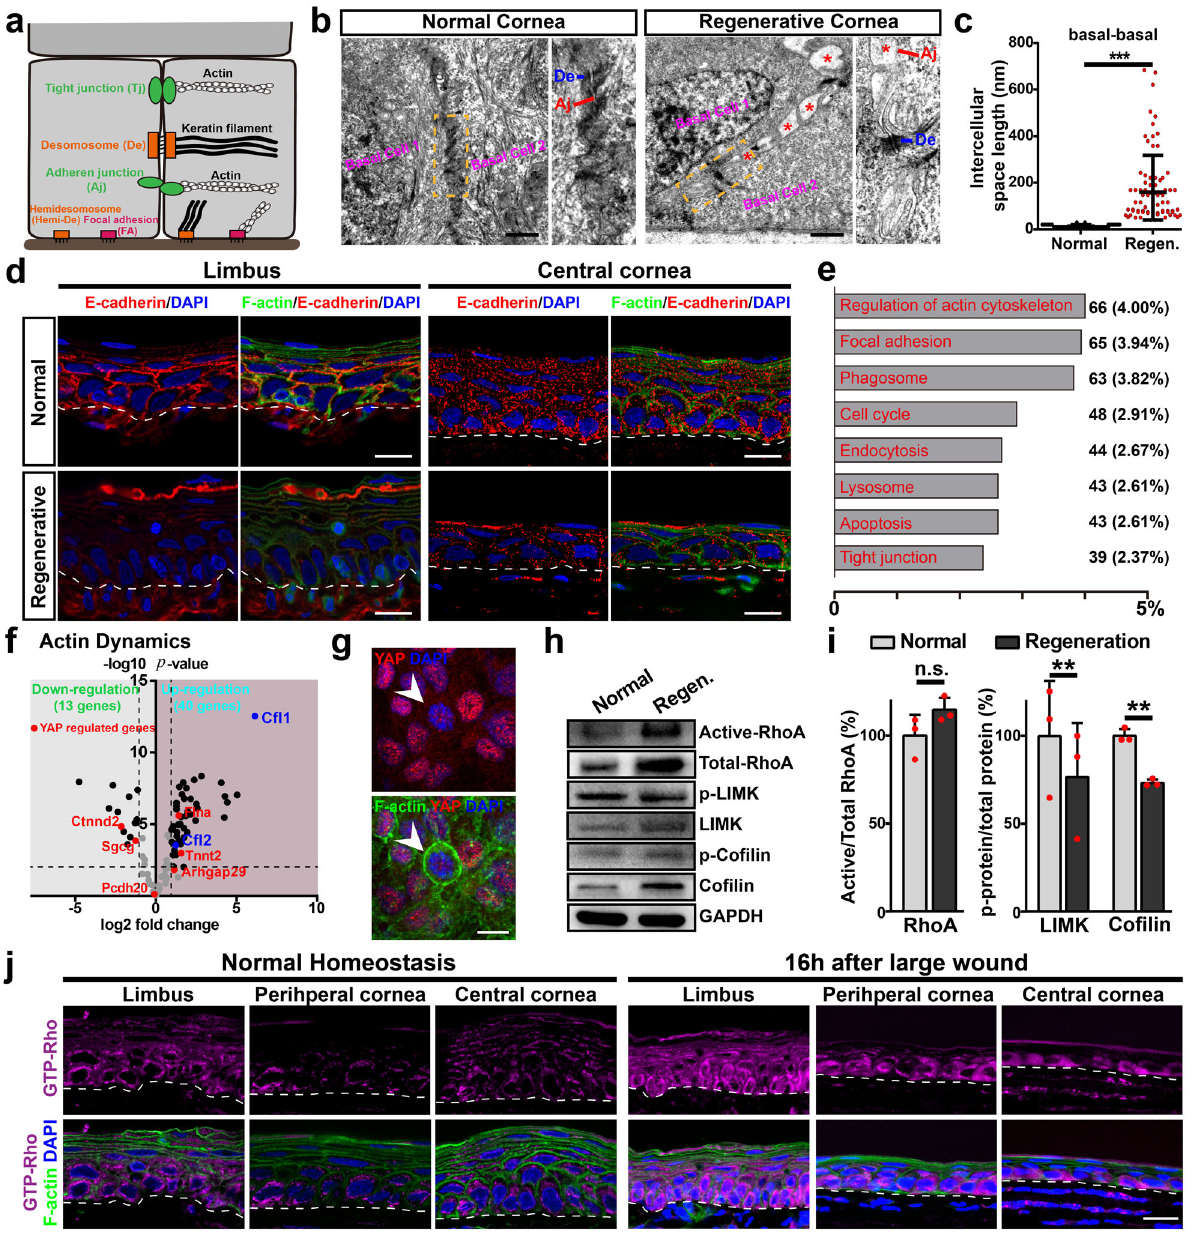
Fig. 4 Loosening of adhesions and disrupted cortical F-actin cytoskeleton during regeneration and repair. a Schematic representation shows three classes of cell – cell adhesions and two classes of cell-ECM adhesions in the corneal epithelium. b TEM images of neighboring epithelial basal cells during normal homeostasis and regeneration at 16 h after large wound. Clear intercellular loosening of Aj at 16 h pw is indicated with asterisks. c Quanti fi cations of intercellular space lengths between neighboring epithelial basal cells during normal homeostasis and regeneration (regen.) at 16 h after large wound. d E-cadherin and fl uorescein-phalloidin stainings of limbal and corneal epithelial cells during normal homeostasis and at 16 h after large wound (regenerative). e Enrichment of differential expressed transcripts in KEGG pathways during corneal wound regeneration. The transcript number and percentage are shown. f Differentially expressed genes that involving actin dynamics during corneal wound regeneration from published genome-wide cDNA microarray data. YAP target genes (red dots and texts) and C fl 1/2, key proteins that regulate actin dynamics, are shown. g YAP and fl uorescein-phalloidin stainings of cultured hCECs. Arrows indicate hCECs exhibit low protein level of YAP with the assembly of cortical F-actin cytoskeleton. h , i Western analysis and quanti fi cation of active RhoA/Total RhoA, p-LIMK/LIMK, and p-Co fi lin/Co fi lin in normal corneal epithelium and regenerative epithelial cells at 16 h after large wound. j Active GTP-bound Rho staining and cortical F-actin cytoskeleton staining during normal homeostasis and regeneration at 16 h after large wound. Scale bars, 1 μ m ( b ) or 20 μ m ( d , g , j ). Data are the mean ± SD, n = 3 experiments ( i ); n.s. not signi fi cant, ** p < 0.01, *** p < 0.001; Student ’ s two-tailed unpaired t -test ( c ) or paired t -test ( i or -knockdown hCECs (with GFP) with non-infected hCECs (without GFP). As a control, hCECs infected with control lentivirus (only expressing GFP) are co-cultured with uninfected hCECs. We observe To evaluate this hypothesis, we overexpress or knockdown YAP enhanced phase brightness surrounding YAP-overexpressing hCECs in hCECs using lentivirus and co-culture these YAP-overexpressing